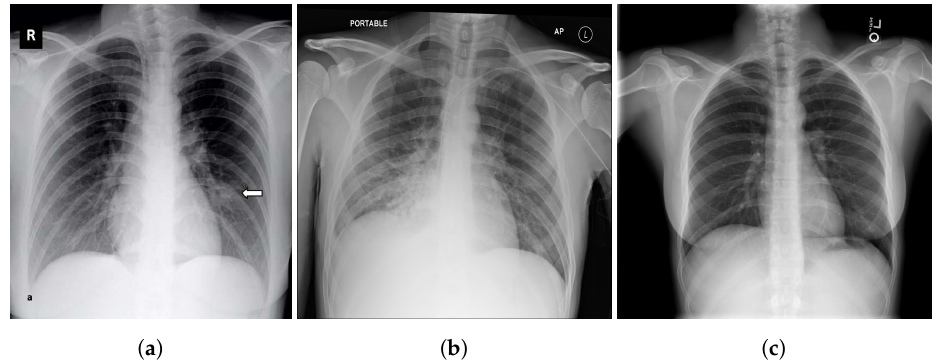
Figure 1. Examples of CXR images: ( a ) COVID-19, the arrow shows the location of the infection; ( b ) pneumonia; ( c )